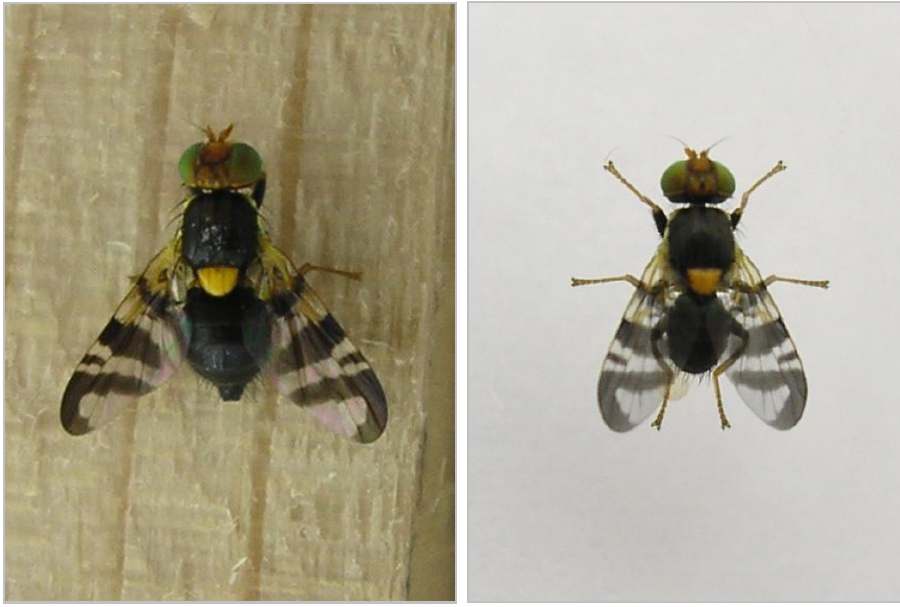
scutellum and characteristic wing pattern and a size of 4 mm (males) to 5 mm